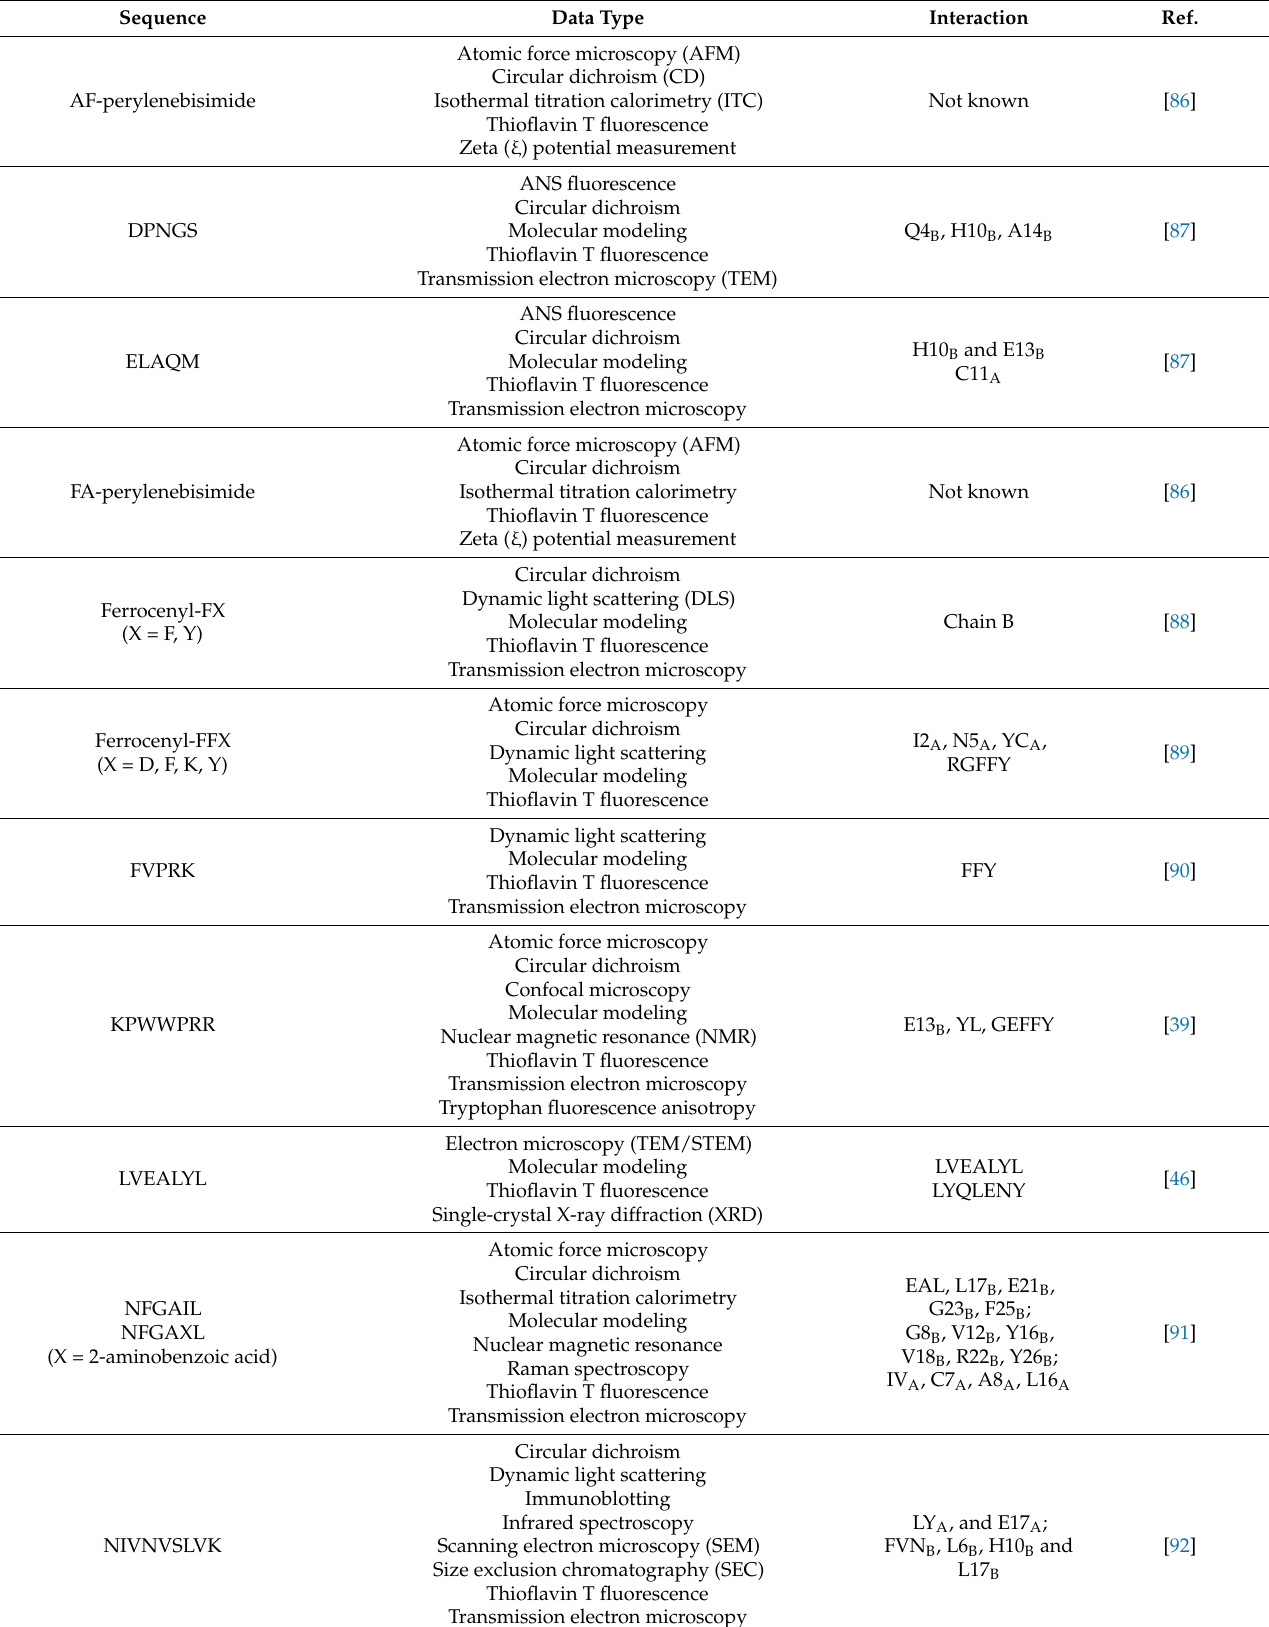
Table 1. Peptide inhibitors of insulin